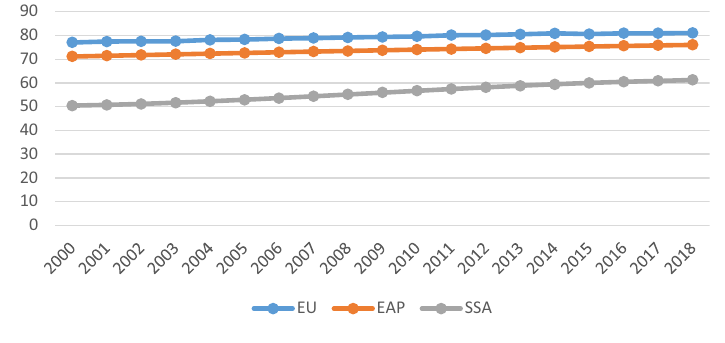
Figure 1. Comparative graphical illustration of life expectancy in